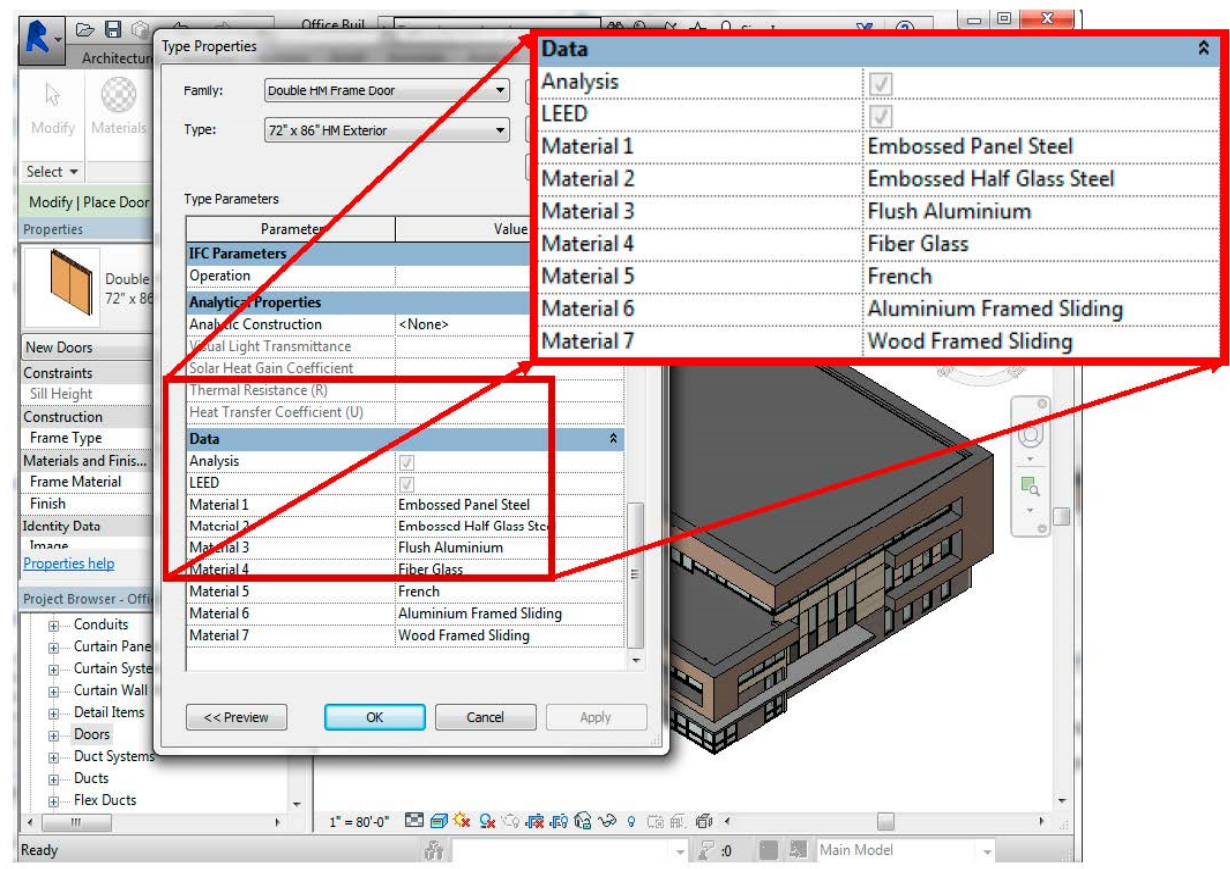
Figure 5. Model interface showing inputs assigned to a door